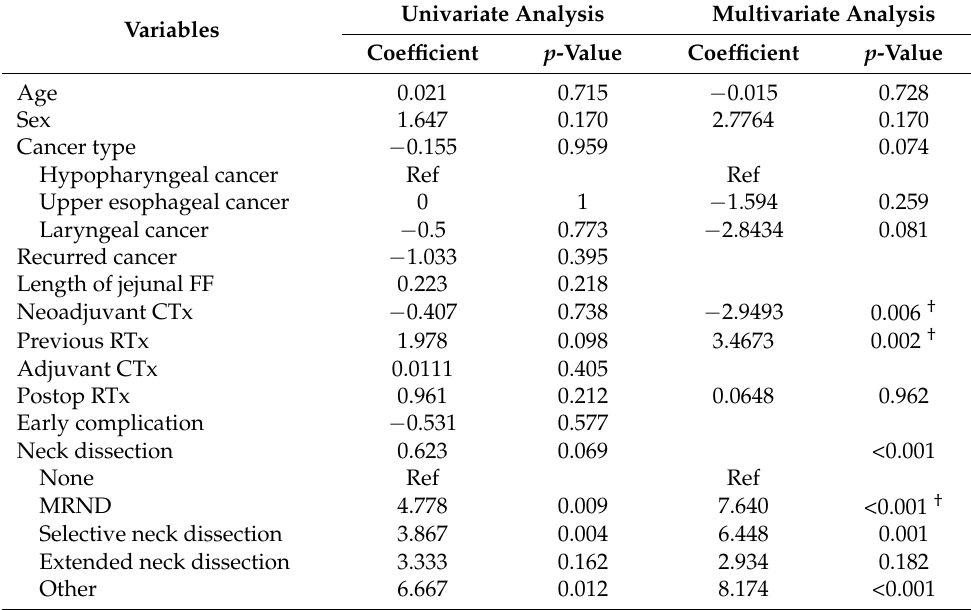
Table 6. Univariate and multivariate analyses for predictors of dietary function.